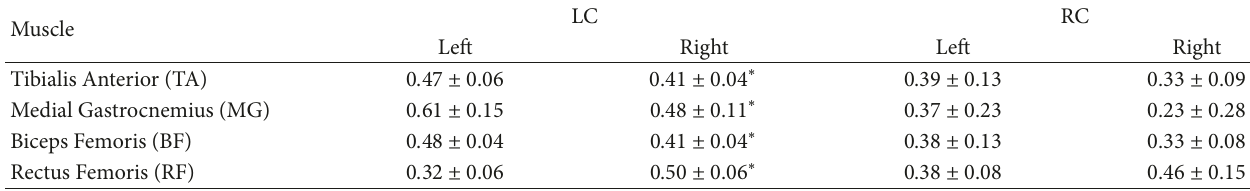
Table 1: Muscle latency (sec).